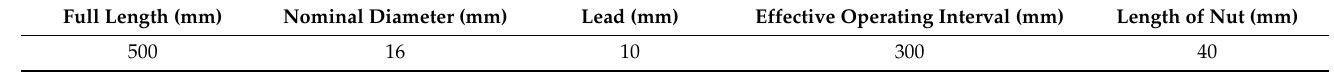
Table 1. Structure parameters of the ball screw nut